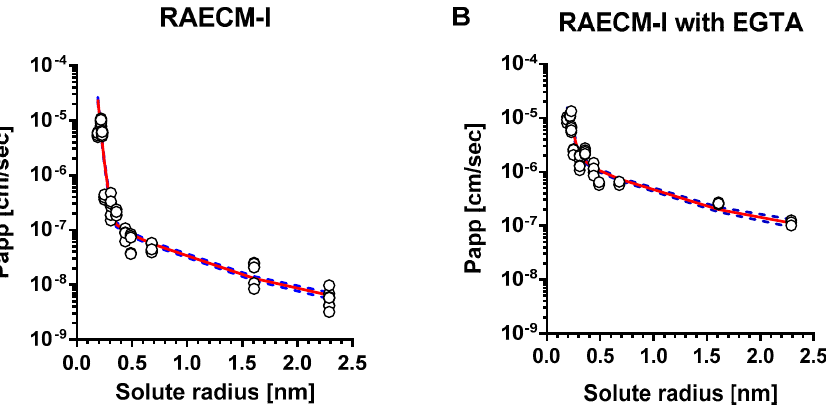
Figure 1. Heteropore analysis of P app across RAECM-I. P app across RAECM-I in the absence ( A ) and presence ( B ) of EGTA were analyzed using a maximum likelihood optimization approach, yielding small and large equivalent pore characteristics shown in Table 4. Circles represent individual P app , and the solid curve in red denotes the composite equivalent pore characteristics that best fit the observed P app versus solute radius data. Blue dotted curves represent solid red curve ± standard errors. Figure A1 in Appendix A shows the relationship between mean values of P app and solute size, similar to that shown above in Figure 1 (based on optimization using all entries of P app ). Table 4. Heteropore characteristics of RAECM-I. Number and radius of small and large equivalent pore populations based on maximum likelihood optimization approach using all entries of P app in the absence and presence of EGTA. Equivalent pore number is per nominal surface area (1 cm 2 ) of RAECM-I.